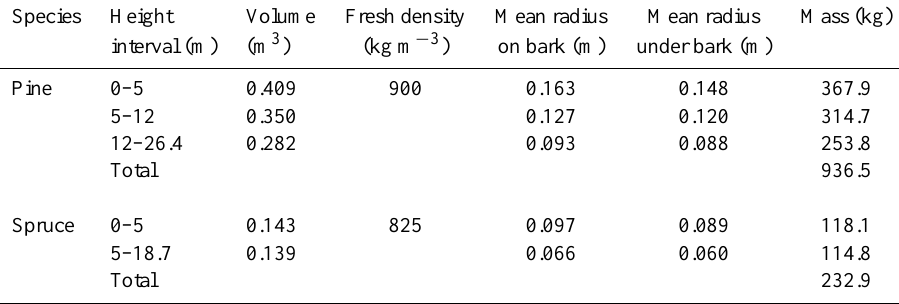
Table 3. Volume and fresh weight for the different stem segments. Species Height Volume Fresh density Mean radius Mean radius interval (m) (m 3 ) (kg m − 3 ) on bark (m) under bark (m) Pine 0–5